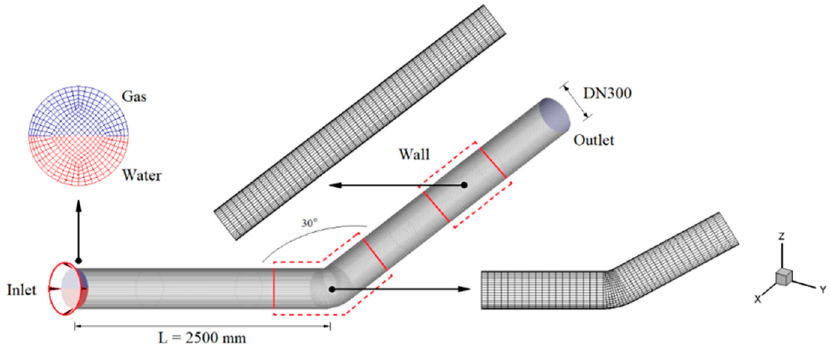
Figure 2. Meshing of the model used in the CFD simulation of an upward-inclined pipeline (30°).